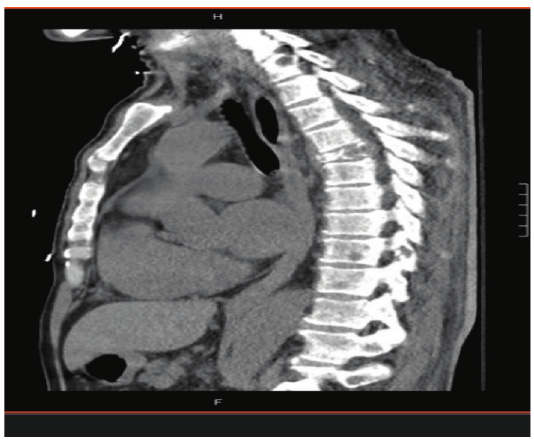
Figure 1: CT scan showing lytic bone